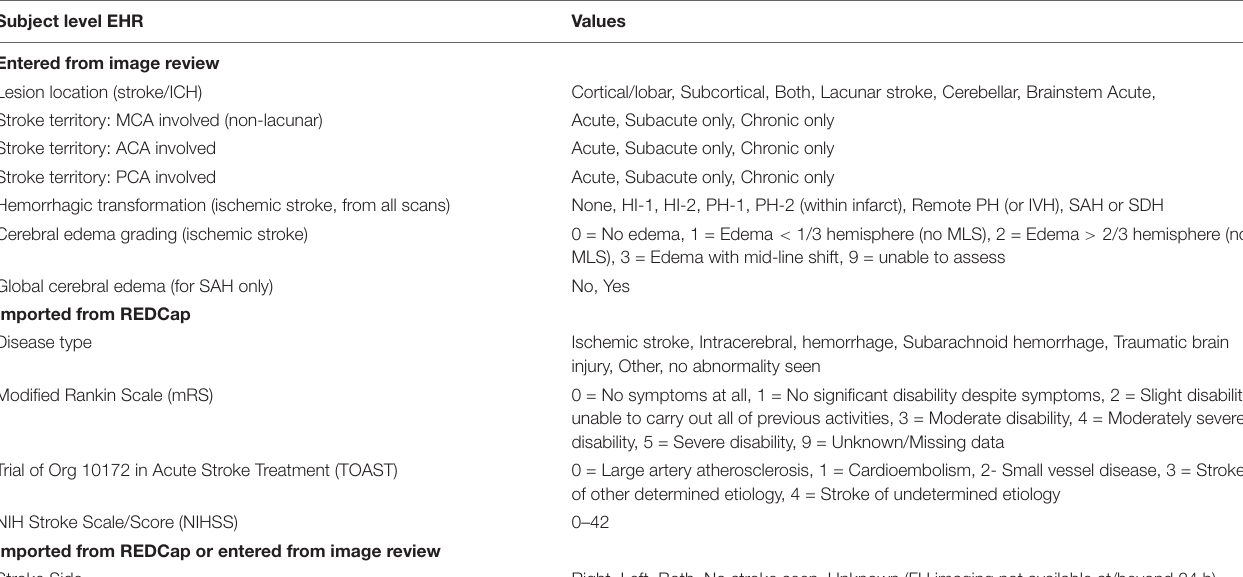
TABLE 1 | SNIPR can pull stroke’s clinical data from REDCap and manage these data at subject